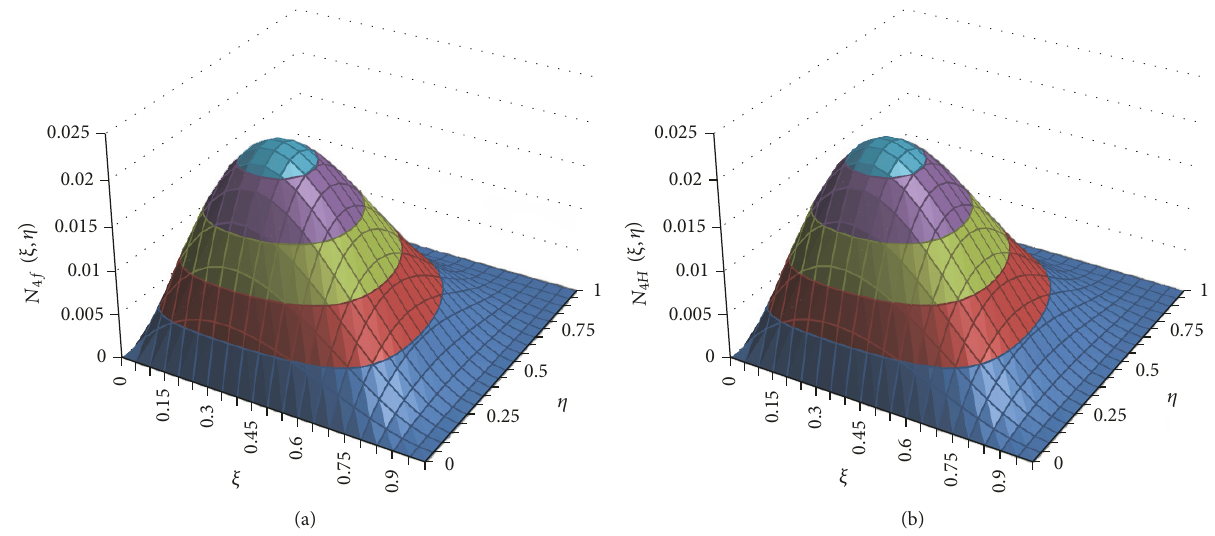
Figure 5: DFE (a) and FEM (b) shape function for 𝜃 𝑥𝑦1 at node